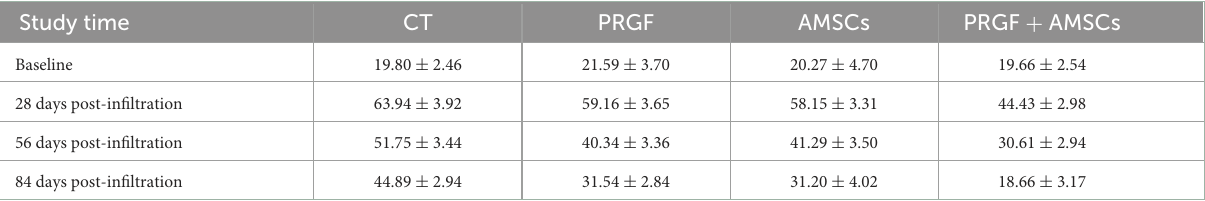
TABLE 1 Serum C2C means standard deviation at different study times and treatment groups.